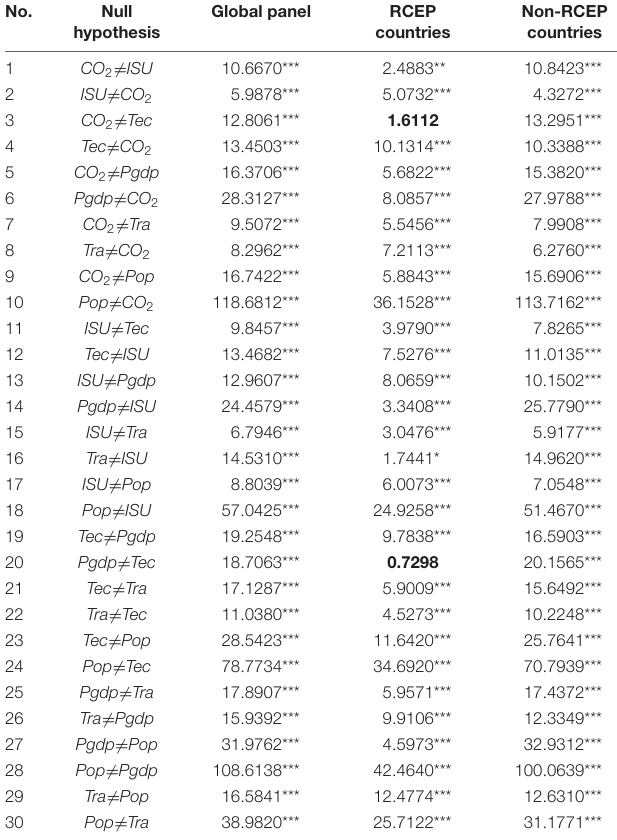
TABLE 7 | Results of the D-H panel causality